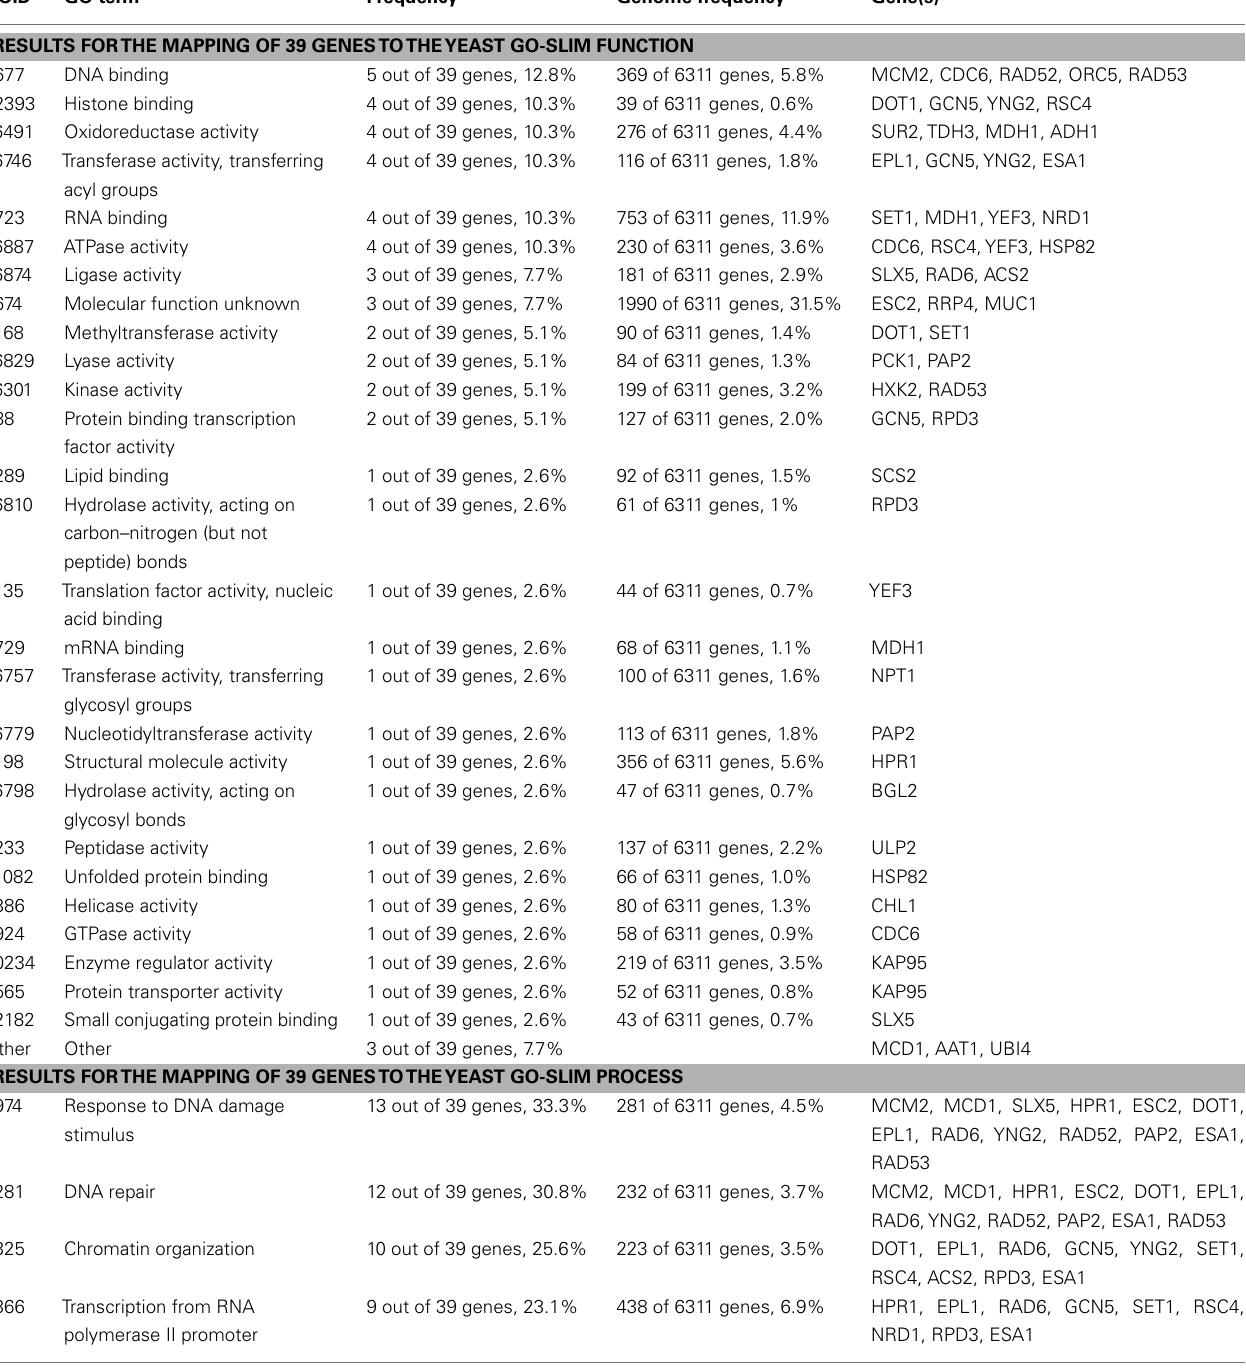
TableA1 | Data analyzed by GO slim mapper, http://www.yeastgenome.org/,